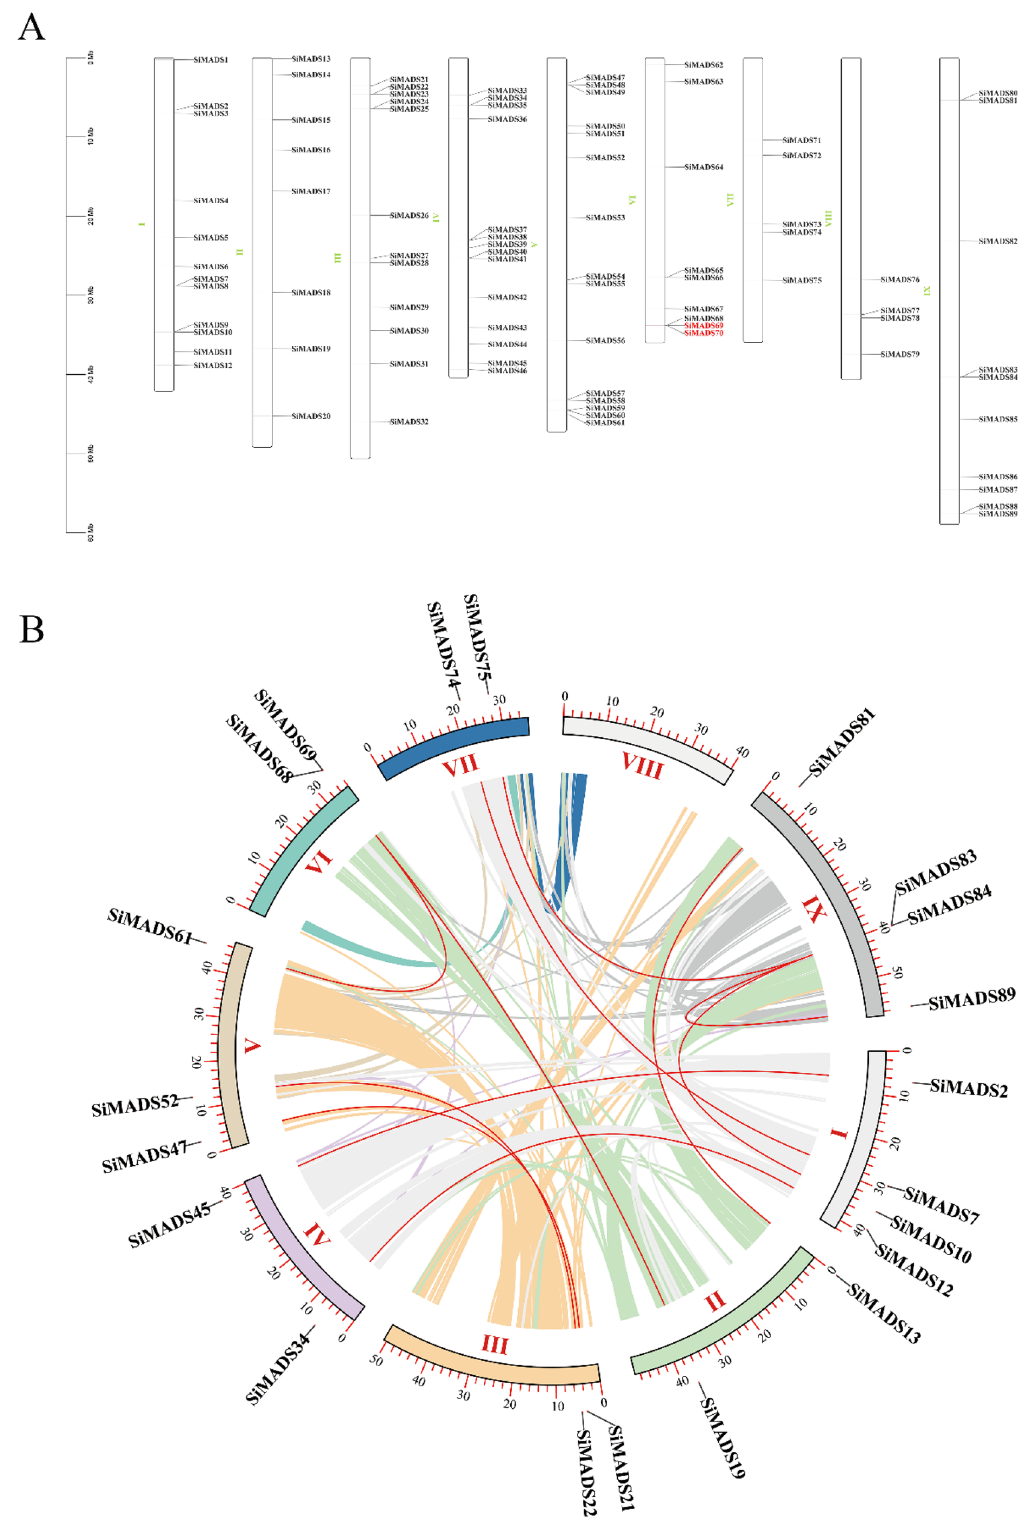
Figure 4. The chromosomal distribution and synteny blocks of the S. italica MADS-box genes. ( A ). Schematic representation of the chromosomal distribution of the S. italica MADS-box genes. Vertical bars represent the chromosomes of S. italica . The chromosome number is indicated to the left of each chromosome. The scale on the left represents chromosome length. ( B ). Schematic representation of the chromosomal distribution and interchromosomal relationships of S. italica MADS-box genes. Colored lines indicate all synteny blocks in the S. italica genome and red lines indicate duplicated MADS-box gene pairs. Chromosome number is indicated at the bottom of each